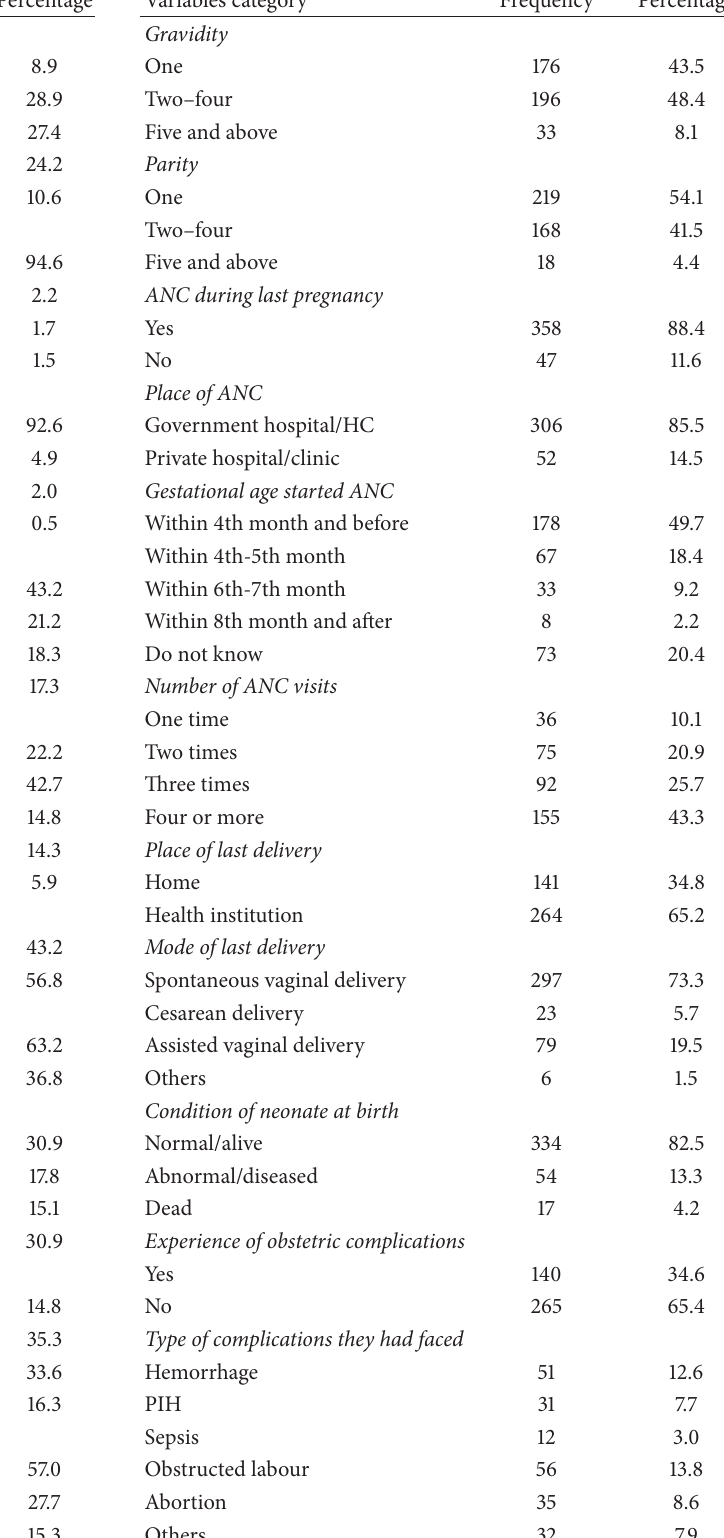
Table 1: Sociodemographic characteristics of postnatal mothers of Mechekel district health centers ( 𝑛 = 405 ), East Gojjam zone,